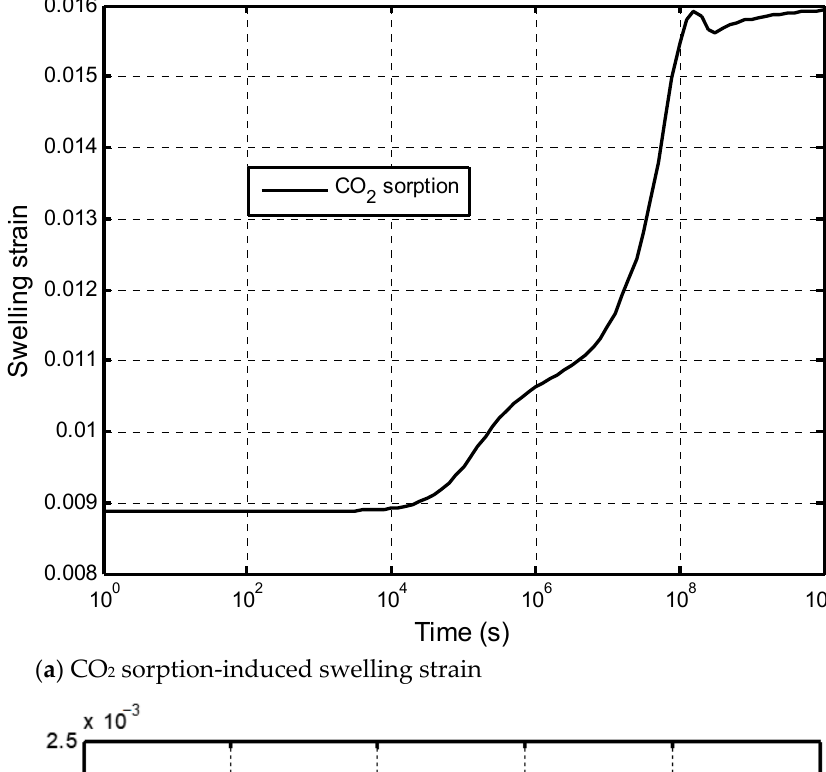
Figure 9. Effect of dehydration on the water saturation in fracture network at 317 years.